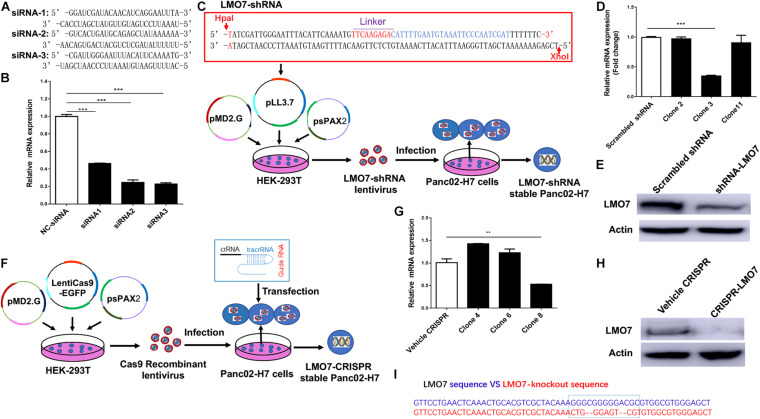
Knockdown or knockout of LMO7 in Panc02-H7 cells with siRNA, shRNA, and CRISPR-Cas9 technologies and establishment of relevant stable cells. (A) The sequences of three designed siRNAs for mouse LMO7. (B) qPCR detected the effective knockdown of LMO7 in Panc02-H7 cells with three designed siRNAs. (C) Schematic diagram of the establishment of stable LMO7-knockdown cells with the shRNA approach. (D) qPCR detected the reduced LMO7 mRNA expression in stable LMO7-knockdown cells developed with shRNA. (E) Western blot detected the reduced LMO7 protein expression in stable LMO7-knockdown cells developed with shRNA. (F) Schematic diagram of the establishment of stable LMO7-knockout cells with the CRISPR-Cas9 approach. (G) qPCR detected the reduced LMO7 mRNA expression in the CRISPR-induced stable LMO7-knockout cells. (H) Western blot showed an undetectable LMO7 protein expression in LMO7-CRISPR Panc02-H7 cells. (I) Sanger DNA sequencing shows the depleted nucleotides in the LMO7 gene in the stable knockout cells. **p < 0.01; ***p < 0.001.